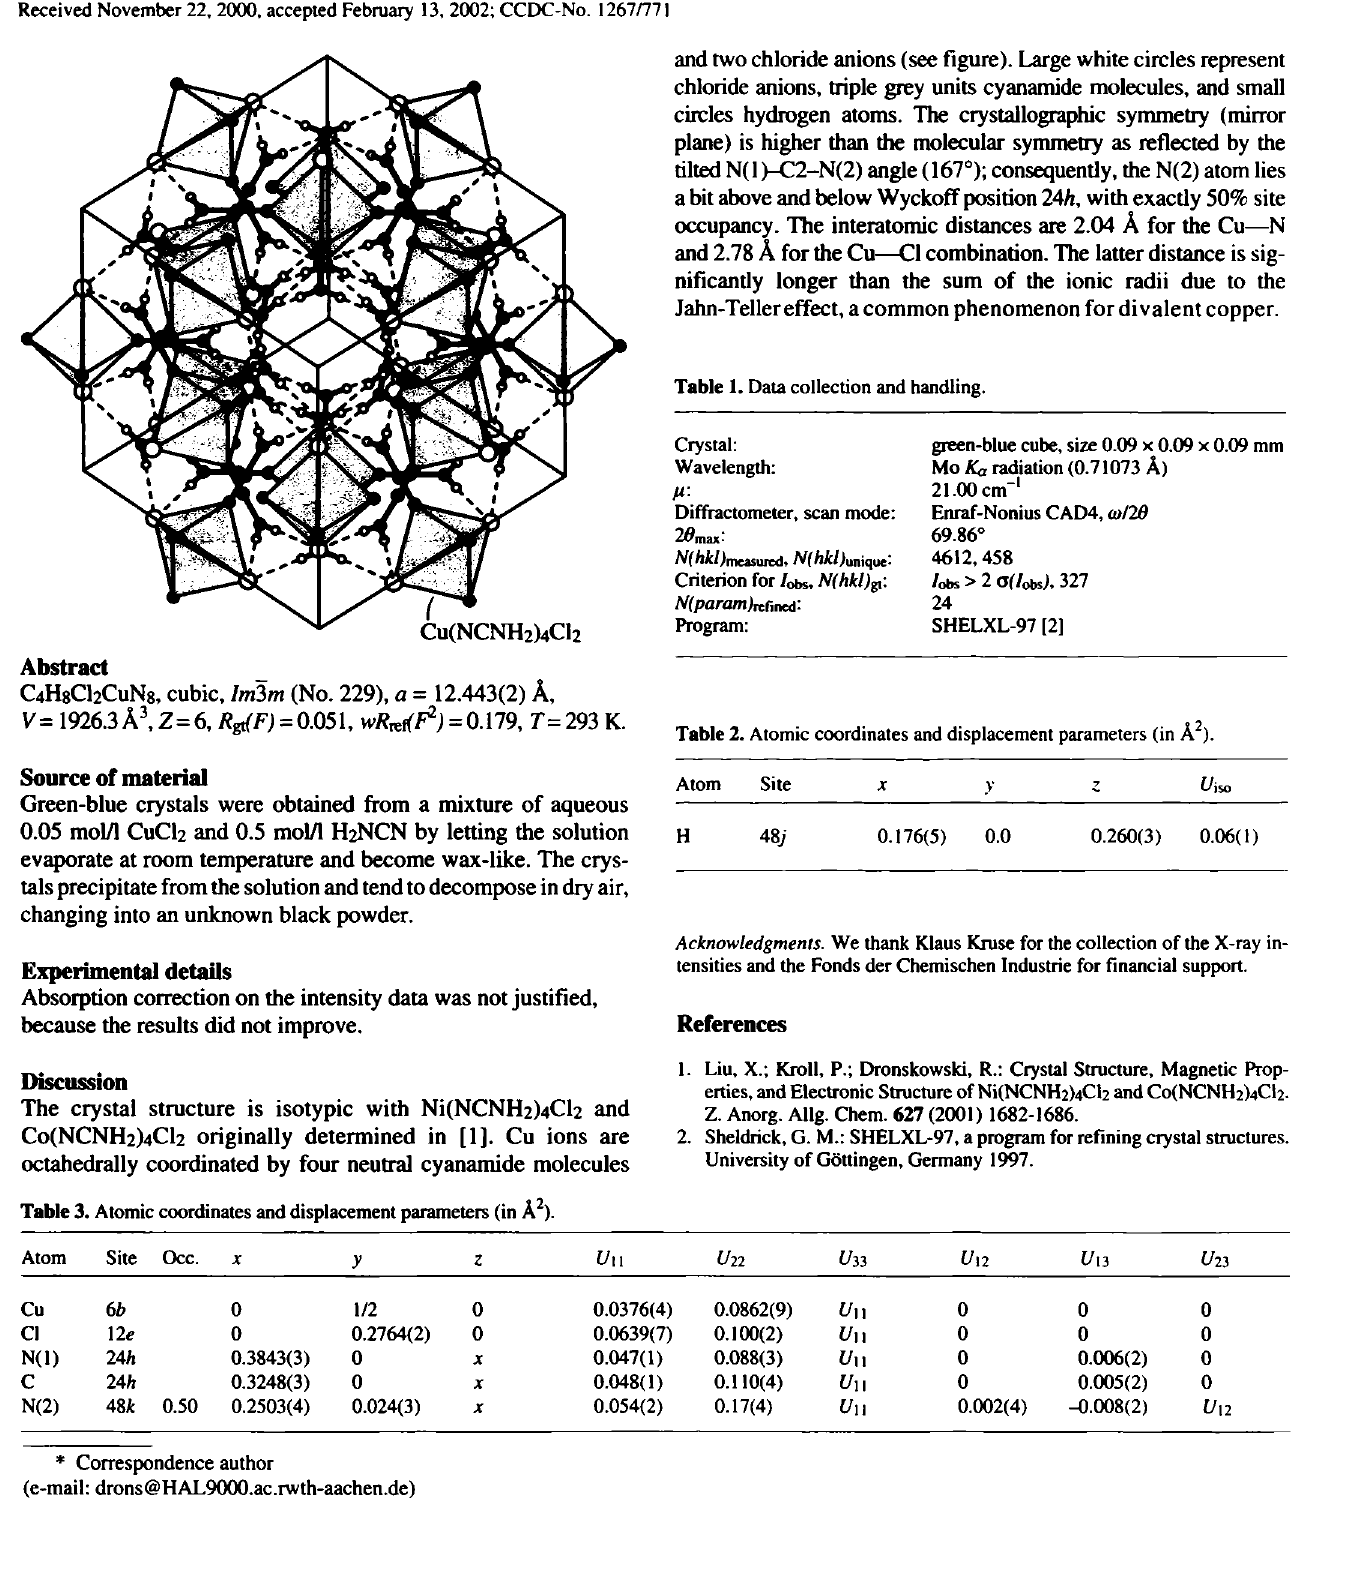
Table 1. Data collection and handling.